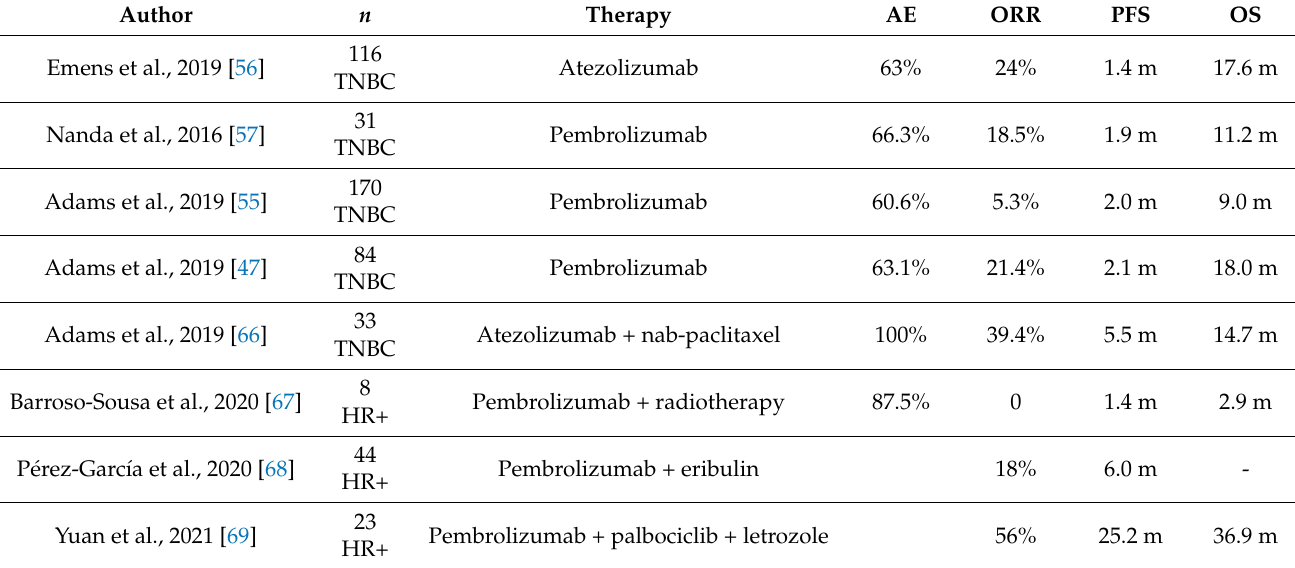
Table 2. Phase I/II evidence for ICPis in advanced breast